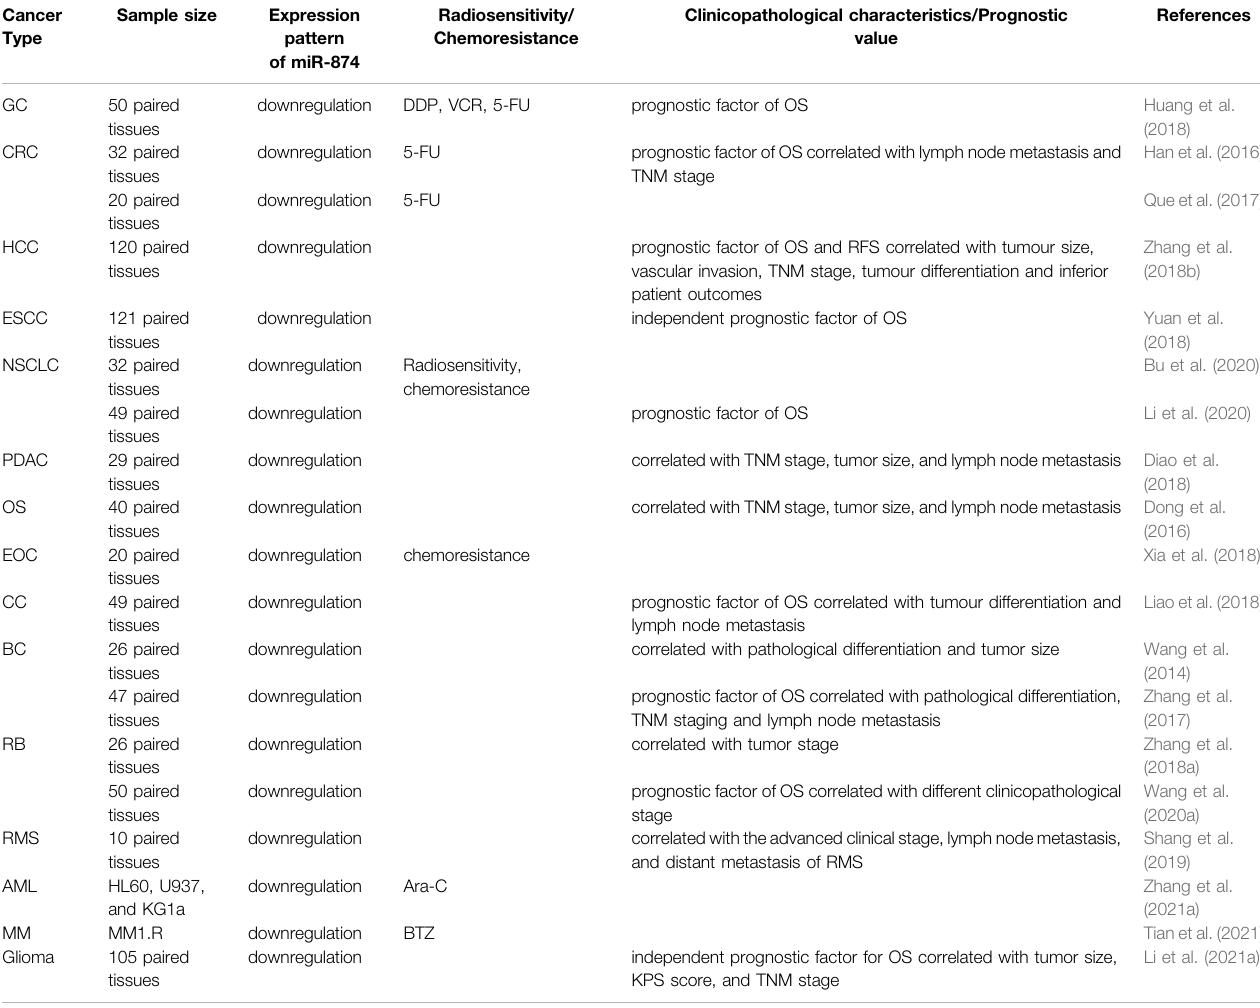
TABLE 3 | The contribution of miR-874 to the treatment, clinicopathological characteristics, and prognosis in cancer. Cancer